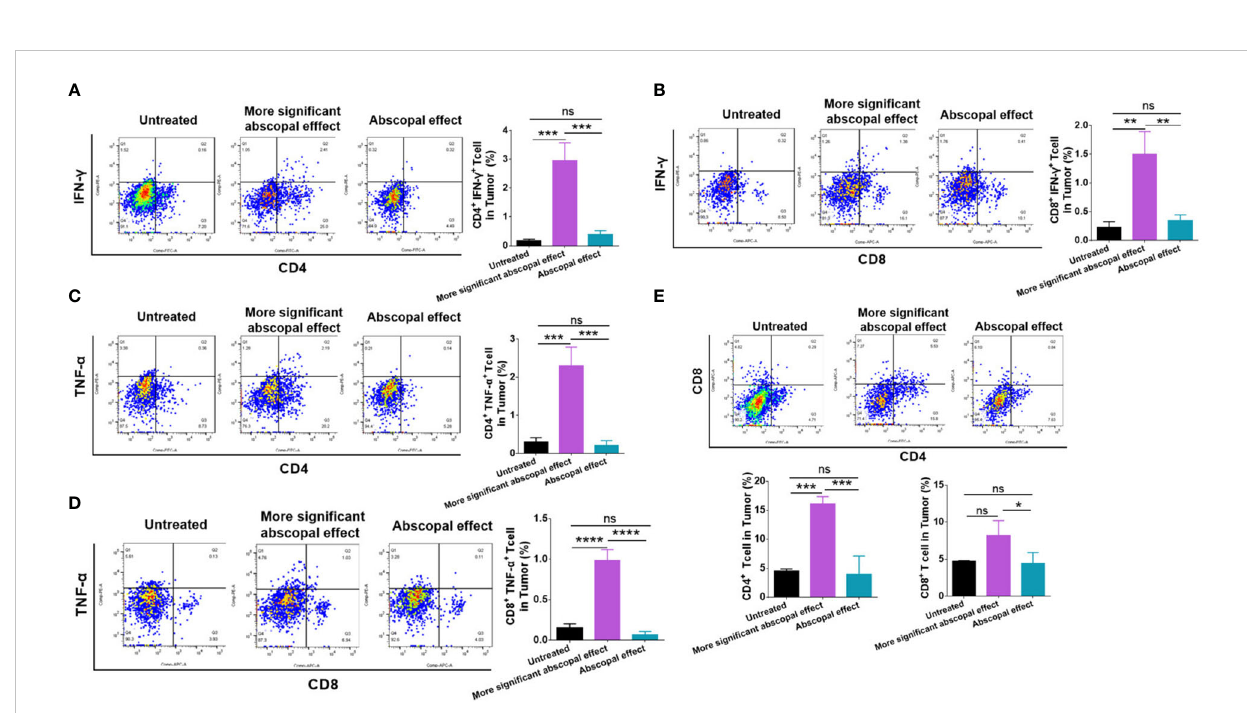
FIGURE 5 The mice presenting signi fi cant abscopal effects after MWA had stronger intratumoral immune activation. The percentages of CD4 + IFN- g + T cells (A) and CD8 + IFN- g + T cells (B) in the abscopal tumor were observed in mice presenting signi fi cant abscopal effect after MWA. The percentages of CD4 + TNF- a + T cells (C) and CD8 + TNF- a + T cells in the abscopal tumor from mice presenting signi fi cant abscopal effect after MWA were identi fi ed. (E) The percentages of CD4 + and CD8 + T cells in the abscopal tumor from mice presenting signi fi cant abscopal effect after MWA were both identi fi ed. ns, p > 0.05; *p < 0.05; **p < 0.01; ***p < 0.001; ****p < 0.0001.